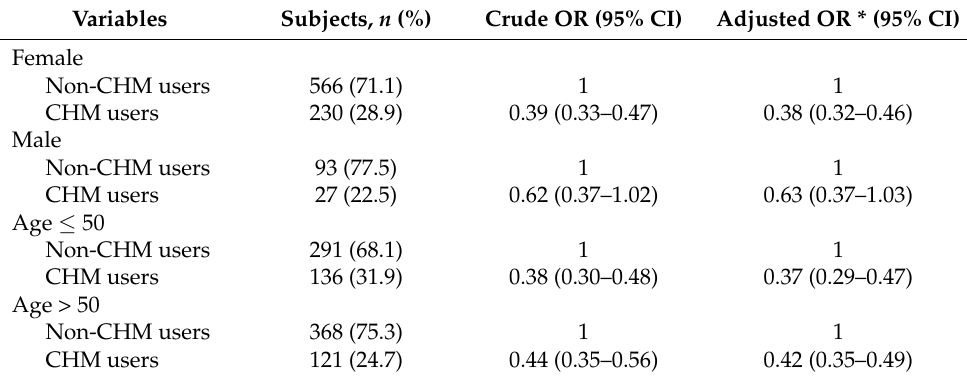
Table 3. SS risk for RA patients with and without CHM use stratified by sex and